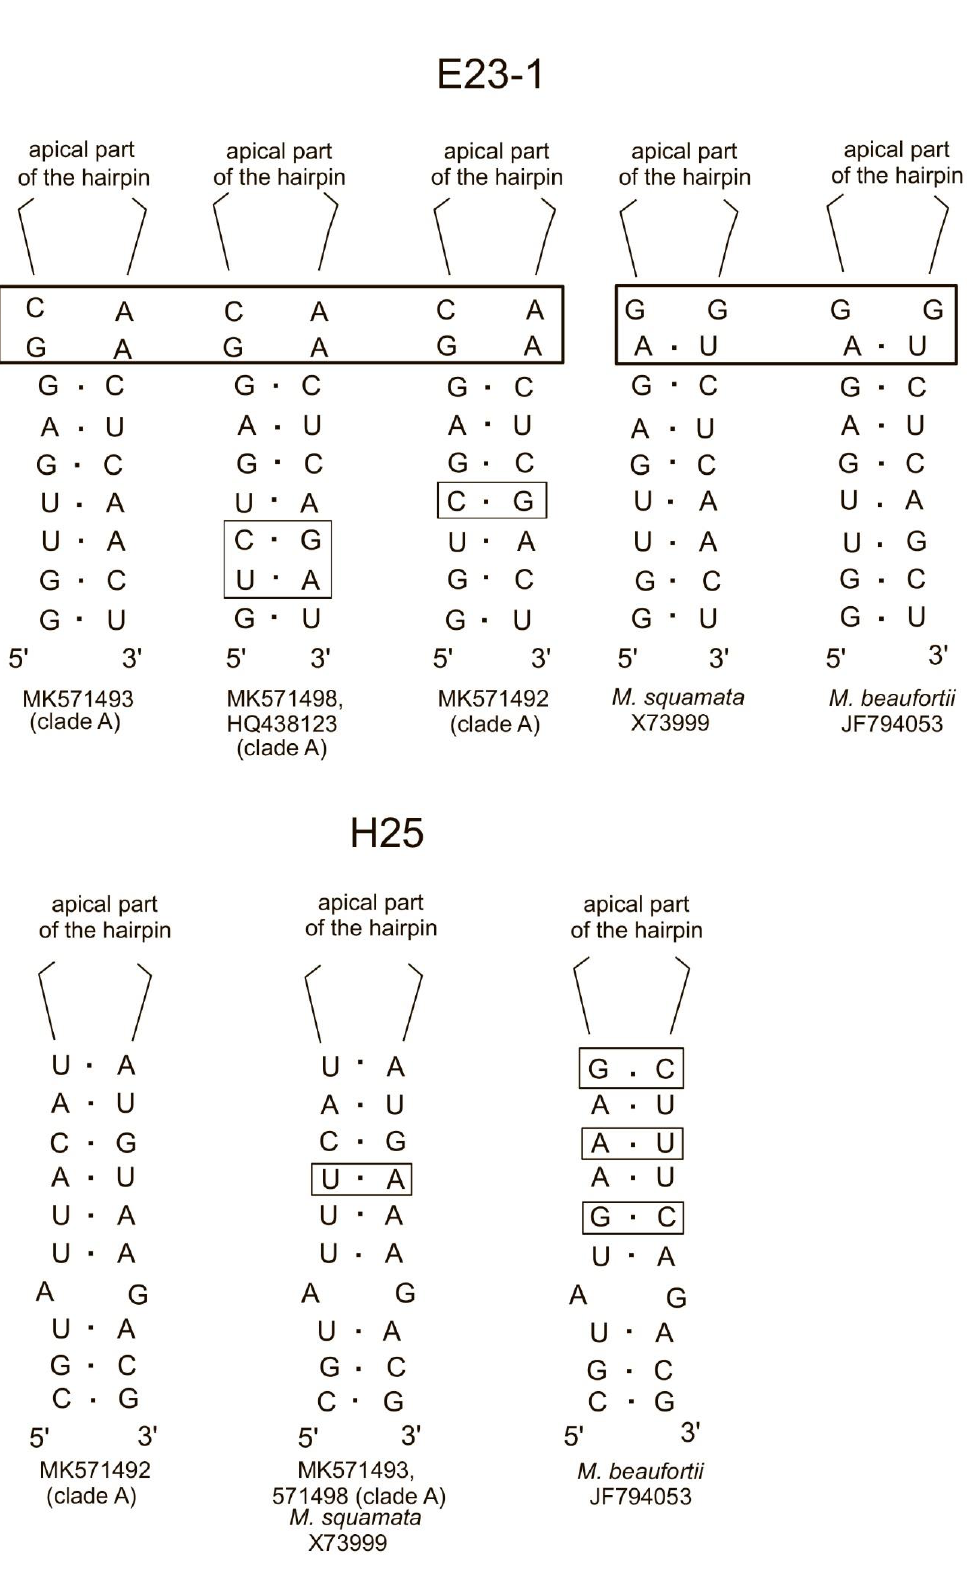
Figure 4. Compensatory base changes in the helices of the 18S rRNA secondary structure of Mantoniella (helices E23_1 and H25). The CBCs are shown in rectangles. Bathycoccus OTUs found in samples 2/13w, 2/14w, 4/14w, and 5/14w were identical (100%) to the Bathycoccus prasinos strain RCC801 (KT860937). The relative read abundance of B. prasinos did not exceed 5% of Mamiellophyceae reads . The OTU matching Ostreococcus tauri (Y15814) was revealed only in sample 5/14w with a low (<1%) relative read abundance. Moreover, in all samples, we